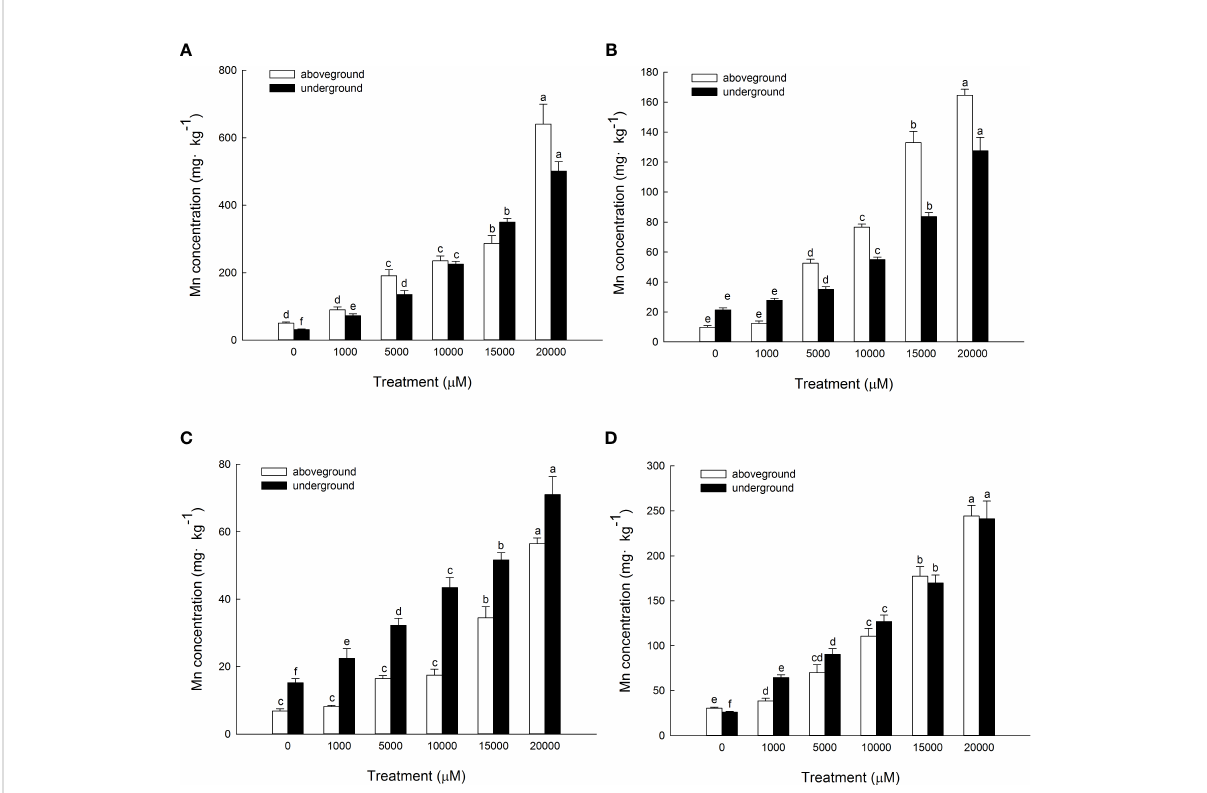
FIGURE 5 Concentrations of Mn in different subcellular compartments in D carota aboveground and underground under Mn stress (mg kg -1 FW) [ (A) cell wall; (B) chloroplasts and cell nuclei; (C) mitochondria; (D) ribosomes)]. Data points and error bars represent mean and S.D. (n = 3). Values with different letters in the same parts of the plant indicate signi fi cant differences at the p < 0.05 level between different Mn concentrations according to the LSD test.